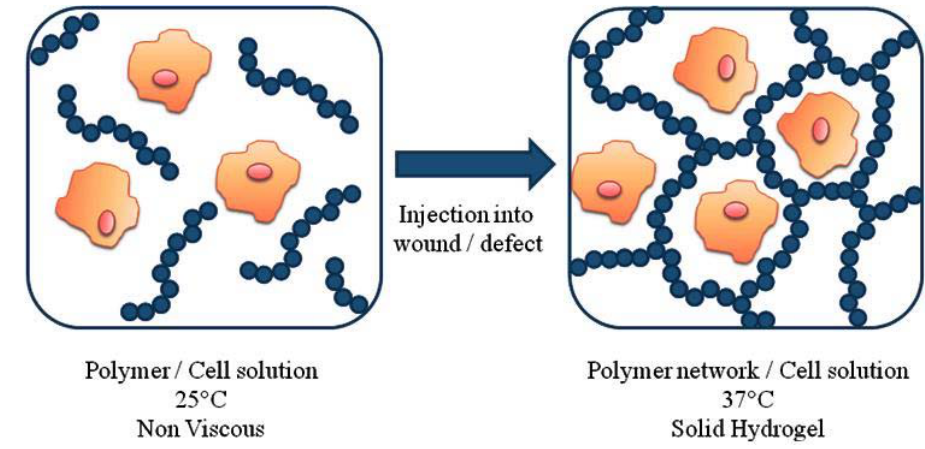
Figure 4. In situ formation of a scaffold in tissue